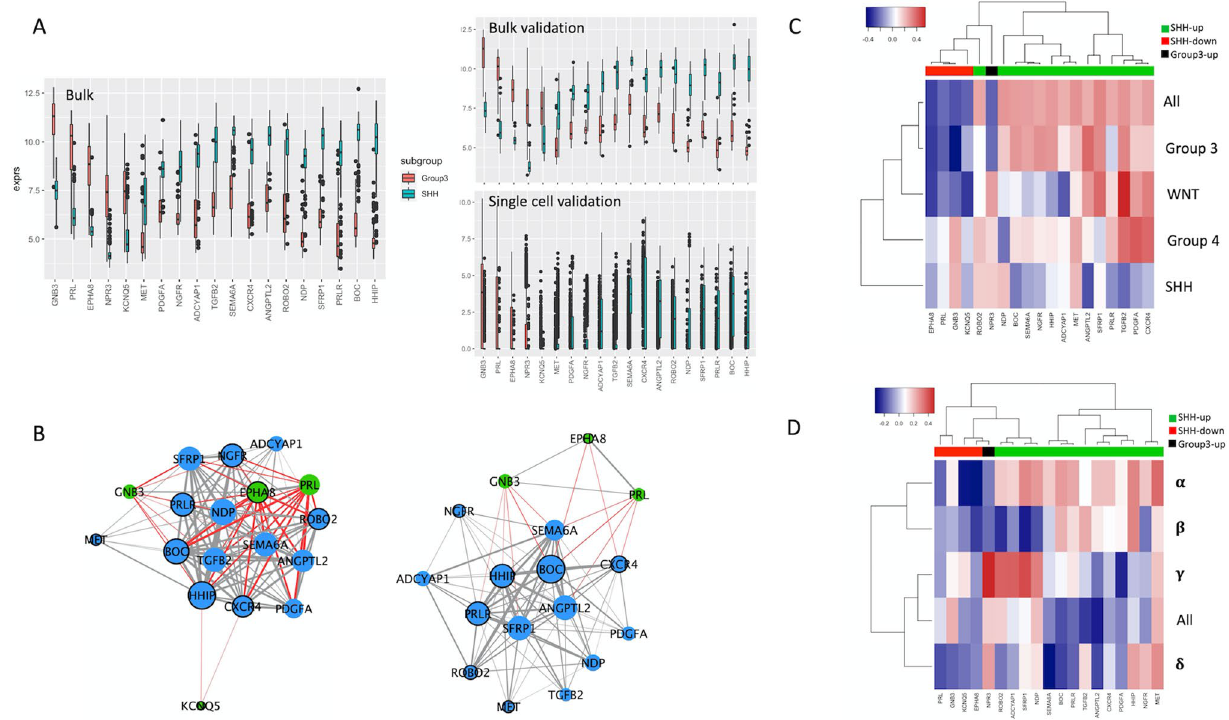
Figure 2. Characterizing stroma-associated receptors/ligands in bulk and single cell data. ( A ) Boxplots comparing the expression of all receptors/ligands of interest (stroma-associates) between SHH and Group 3 medulloblastoma. Genes expressed in < 1% of single cells are excluded, as are genes in the stromal signature panel. Discovery cohort is plotted on the left, bulk validation is right upper and single cell data is right lower. ( B ) Network analysis of genes from ( C ) in bulk (left) and single cell (right) data. Edge thickness is proportional to absolute Pearson correlation (minimum 0.6 in bulk, 0.2 in single cell, all p < 0.05), with red lines indicating negative correlation. Node size correlates with its closeness centrality. Blue nodes represent SHH-upregulated/ Group 3-downregulated/stroma-correlated genes, whereas green nodes represent Group3-upregulated/SHH- downregulated/stroma-anticorrelated genes. Nodes with borders are receptors and those without are ligands. C: Heatmap indicating subgroup-specific Pearson correlations between stromal score and selected stroma- associated genes from Fig. 1. Colour bar above represents correlation of receptor/ligand gene expression with subtype label. Note that GNB3 is both SHH-downregulated and Group 3-upregulated, while the reciprocal is true of BOC. ( D ) Heatmap indicating SHH subtype-specific Pearson correlations between stromal score and stroma-associated genes. Colour bar as in